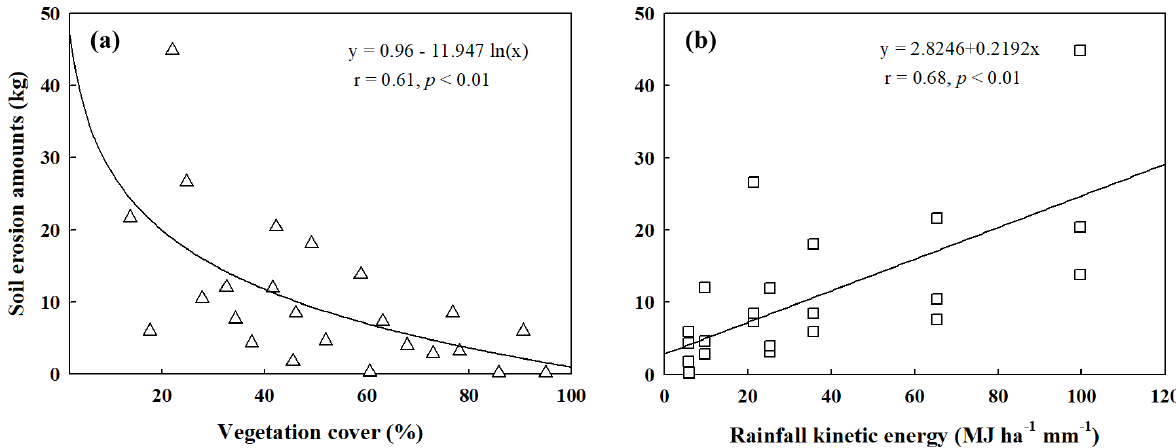
Figure 7. Regression analysis of ( a ) soil loss and VC and ( b ) rainfall kinetic energy.